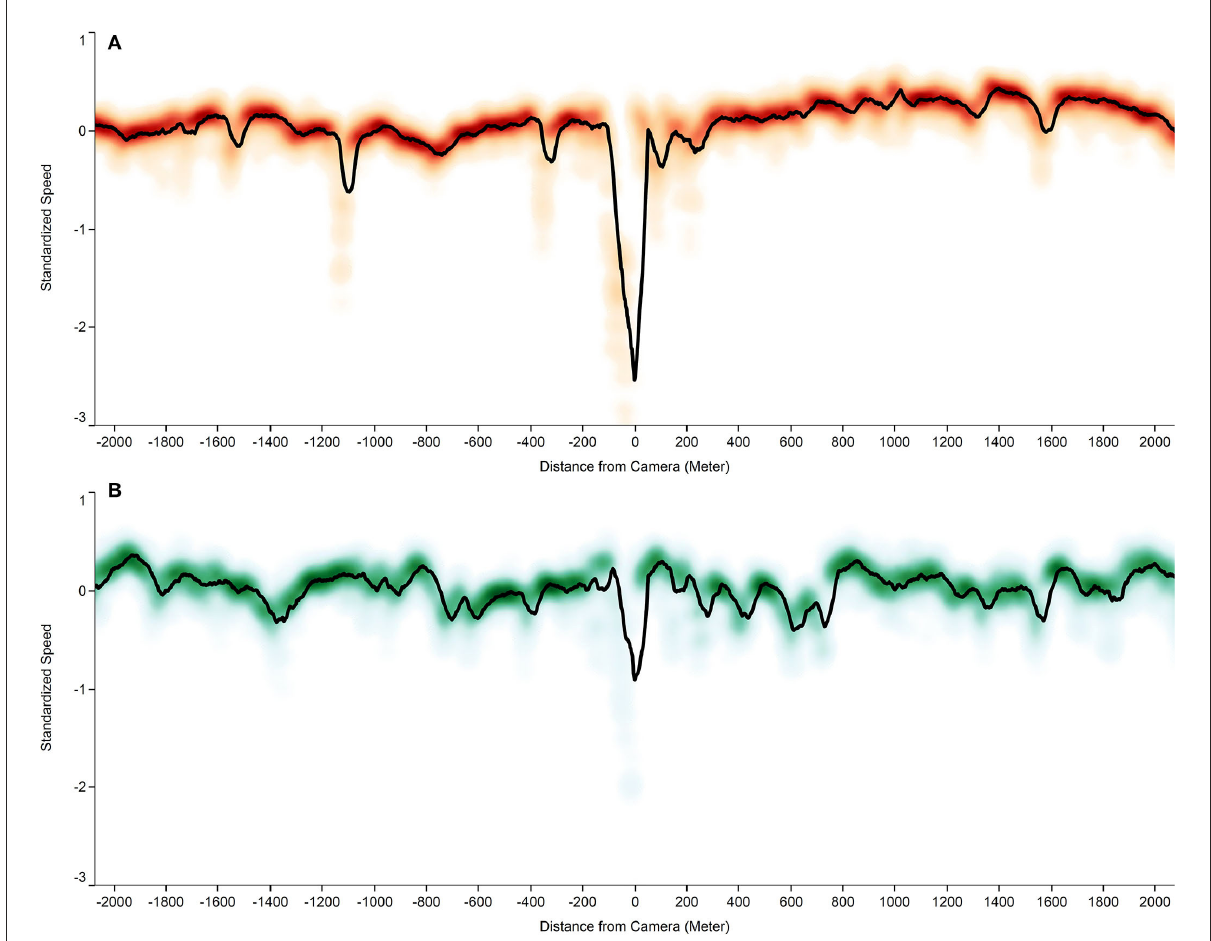
FIGURE2 The speed density of vehicles around urban fixed speed cameras (FSCs), by clustering status. (A) Standardized speed density of vehicles in the vicinity of solitarily located cameras; (B) Standardized speed density of vehicles in clustered camera